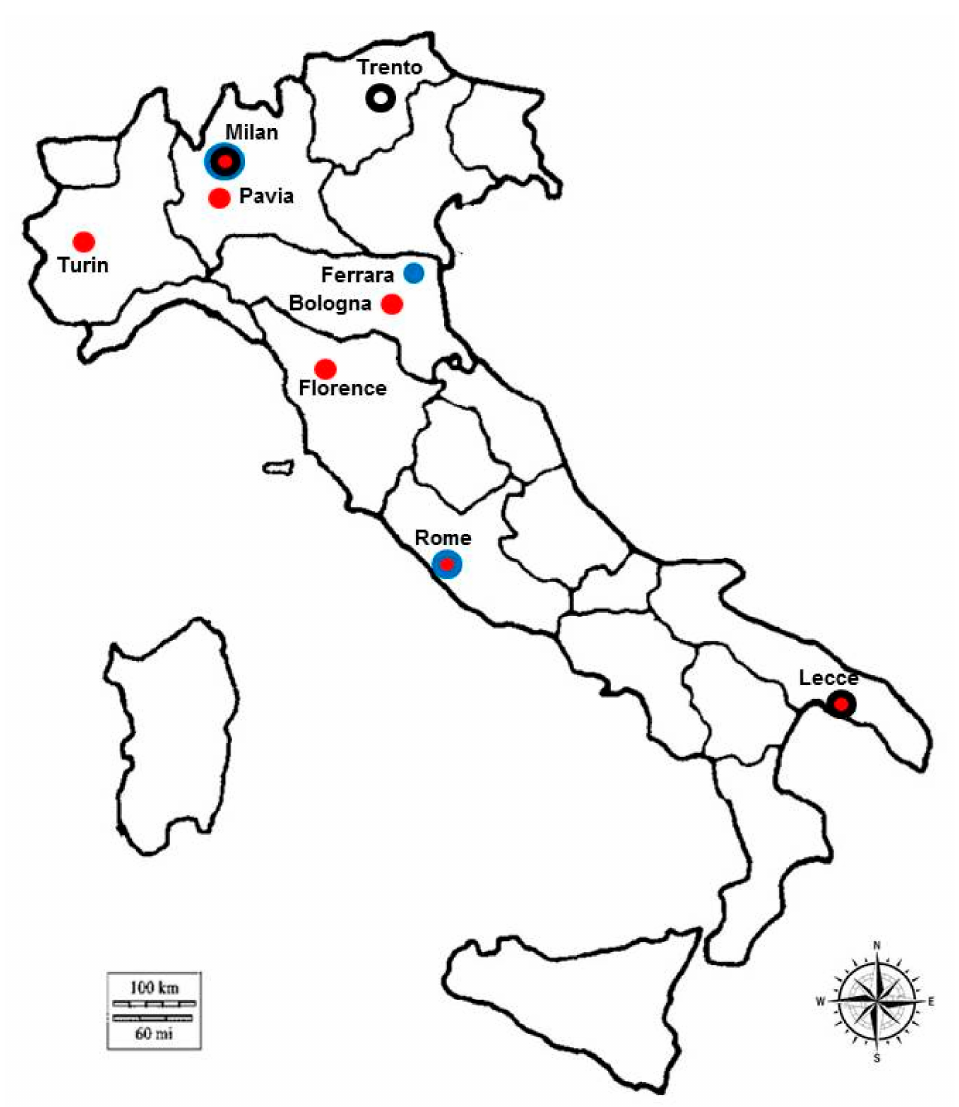
Figure 1. Location of the studied sites across the Italian peninsula. Symbols indicate di ff erent PM size fractions investigated in each site, i.e., black points: PM 10 ; red points: PM 2.5 ; blue points: Other PM size